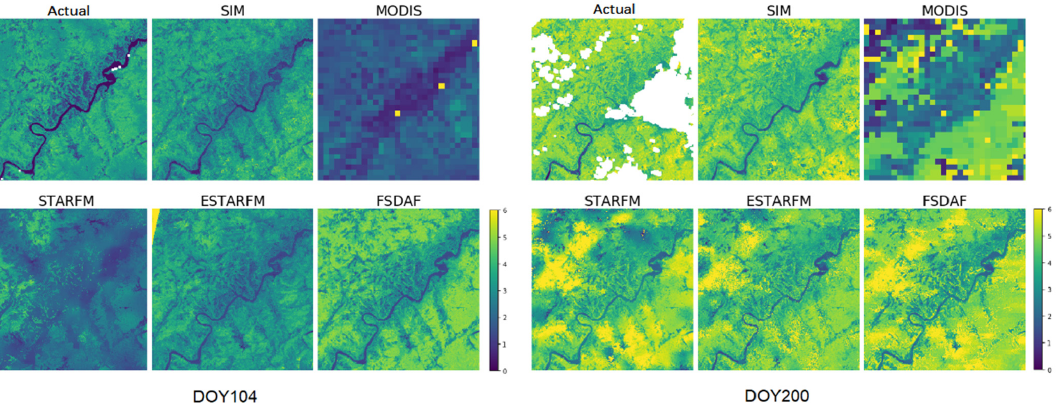
Figure 14. Actual and predicted LAI images using different methods at the CCN area from DOY 104 and DOY 200. Table 11. Accuracies of different methods for LAI prediction at the CCN area from DOY 104 and DOY 200.